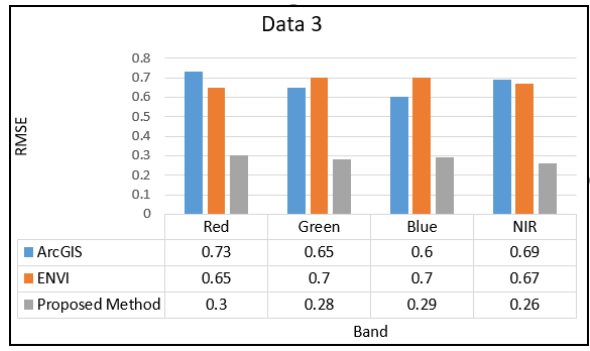
Figure 19 . Compare the precision of the proposed method with the ENVI and ArcGIS